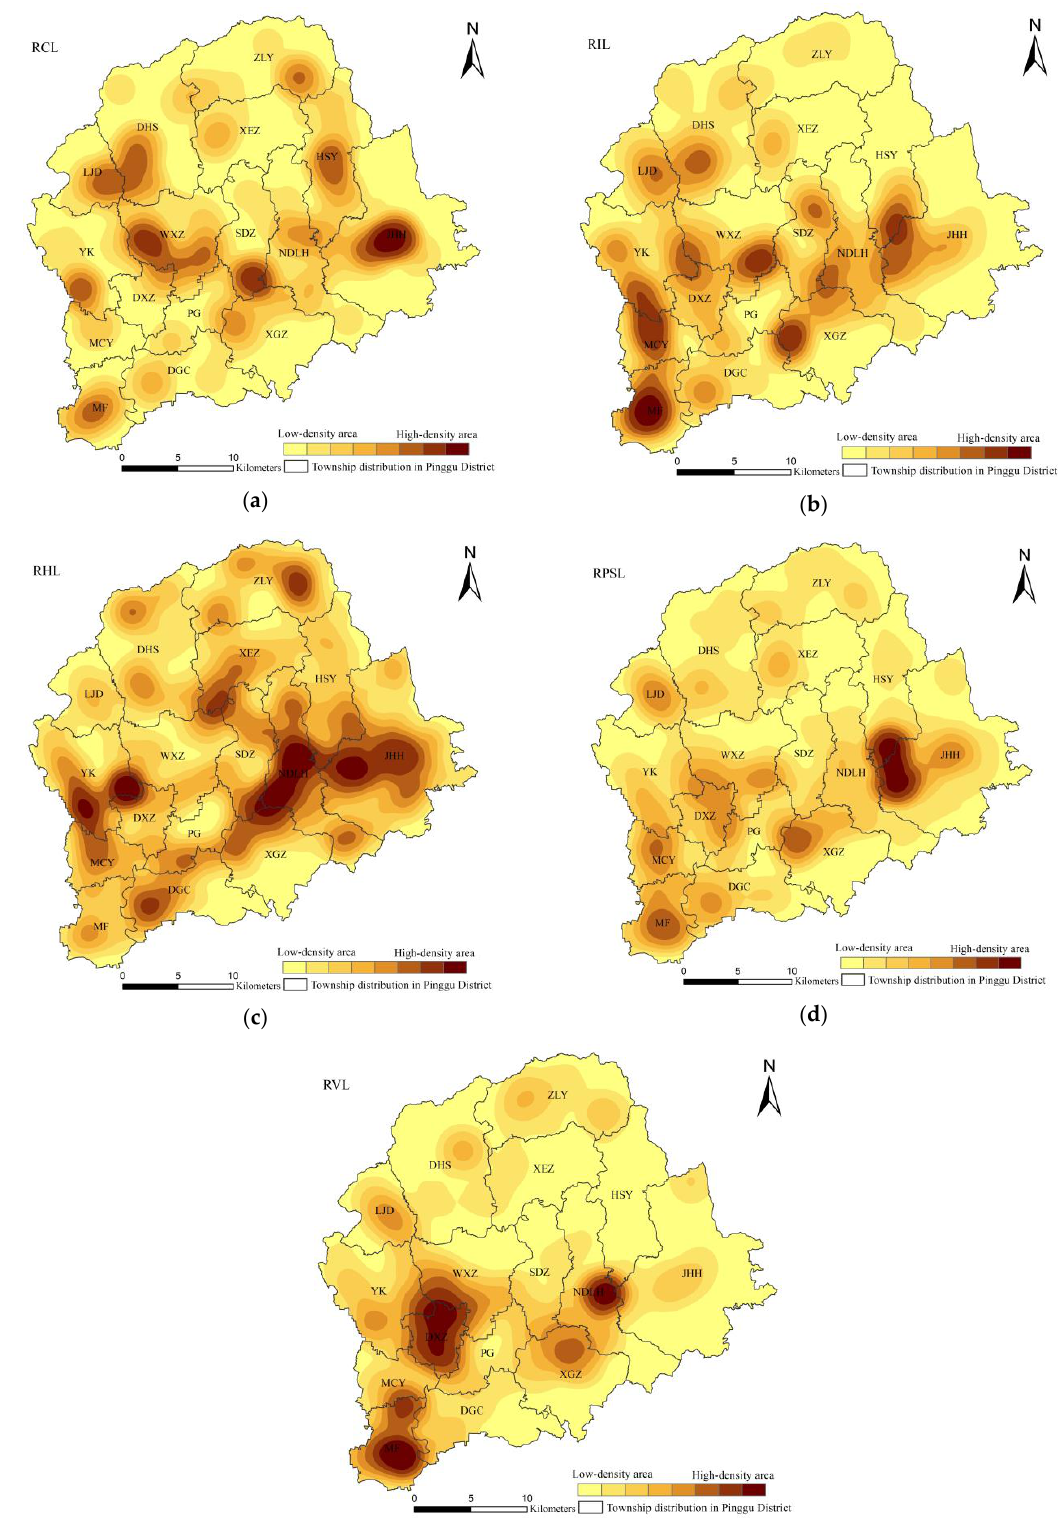
Figure 6. Distribution of the kernel density of the RSILUS in 2025. ( a ) Distribution of the kernel density of RCL. ( b ) Distribution of the kernel density of RIL. ( c ) Distribution of the kernel density of RHL. ( d ) Distribution of the kernel density of RPSL. ( e ) Distribution of the kernel density of RVL.